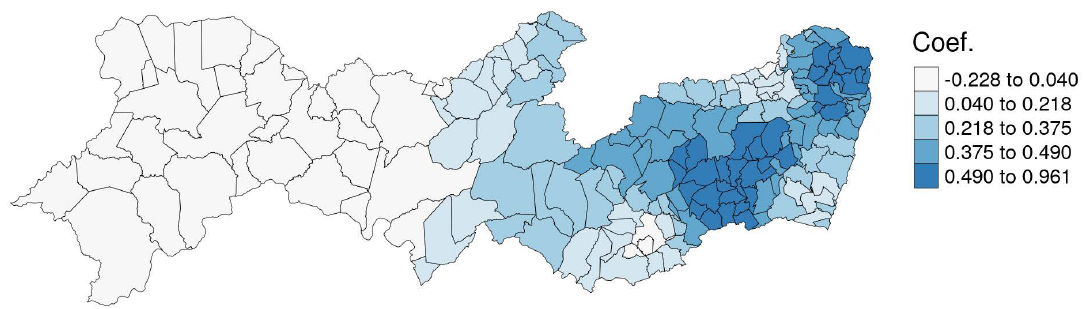
Figure 9. Distribution of the local coe ffi cients of the GWR model (Degree of